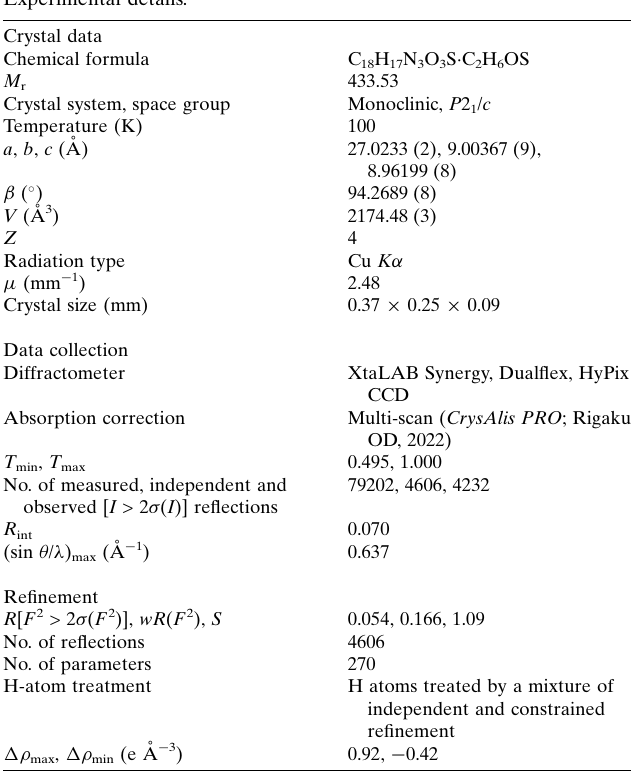
Table 2 Experimental details.